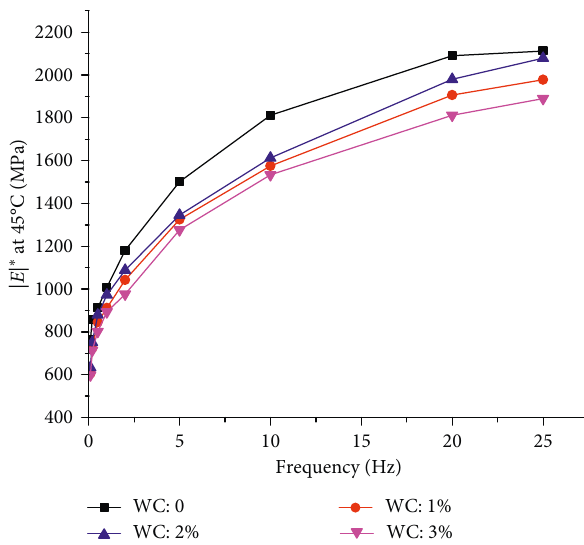
Figure 14: 90#AC-20-type high-temperature dynamic modulus.